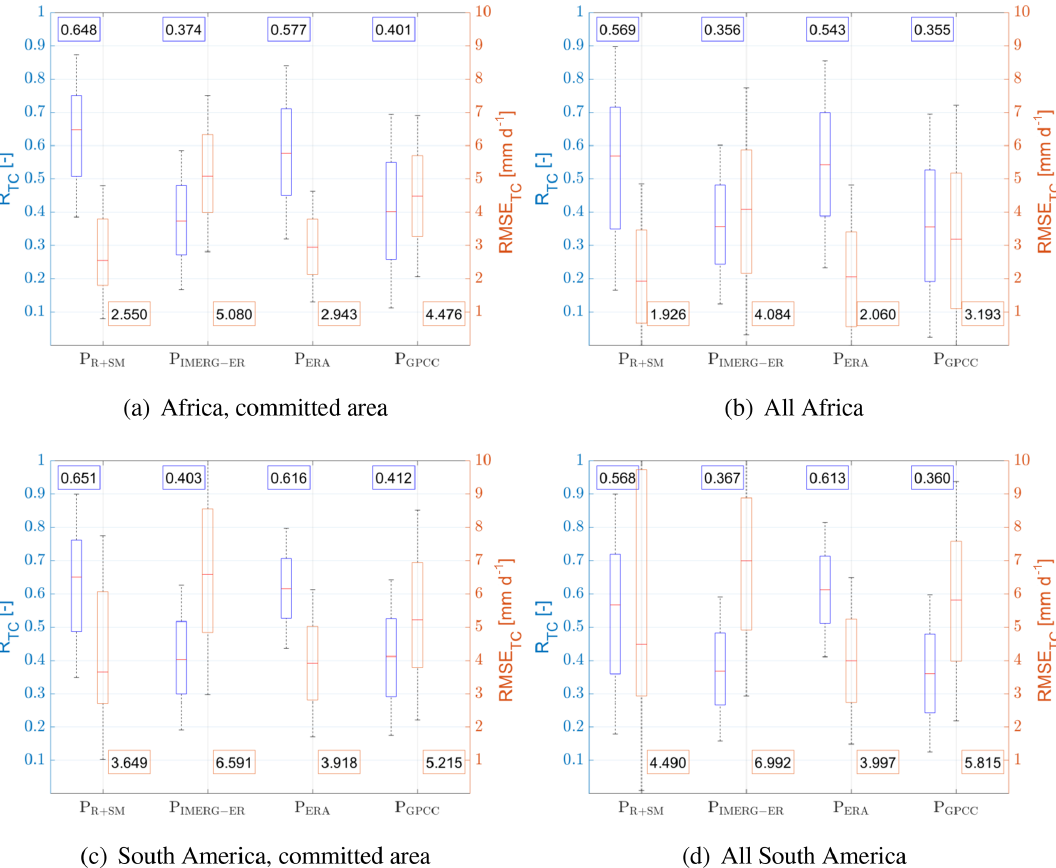
Figure 11. Box plots of triple-collocation squared correlation ( R 2 ; left axis in blue) and root mean square error (RMSE TC ; right axis in red) T in millimetres per day obtained during validation period (i.e. 2018) in Africa over the committed area mask (a) and over the whole study area (b) . Panels (c) and (d) refer to the same results but in South America. The box plot refers to the 25th and 75th percentiles, while the whiskers refer to the minimum and maximum